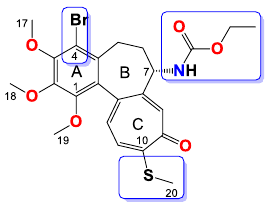
Figure 7. Structure of compound 7 .